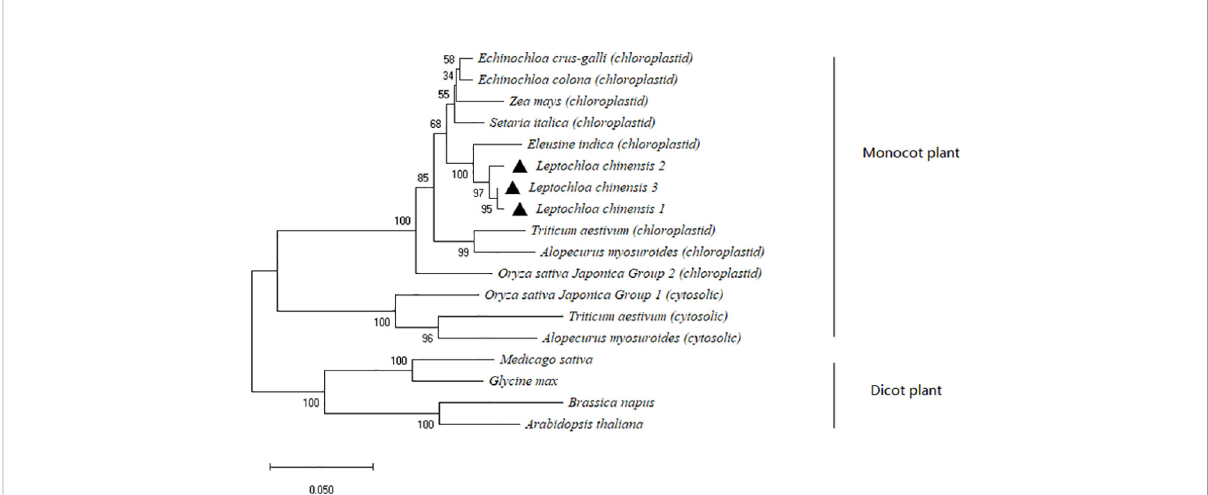
FIGURE 1 Phylogenetic analysis of the plant ACCase CT domain by the neighbor-joining method. (1) Each of the three types of ACCase CT domain in the susceptible Leptochloa chinensis population is labeled by a black triangle. (2) Monocot chloroplastid: Echinochloa crus-galli (NCBI accession No. ADR32358); Echinochloa colona (NCBI accession No. APZ87886); Zea mays (NCBI accession No. AAA80214); Setaria italica (NCBI accession No. AAL02056); Eleusine indica (NCBI accession No. AHC53984); Triticum aestivum (NCBI accession No. AAC39330); Alopecurus myosuroides (NCBI accession No. CAC84161); Oryza sativa Japonica Group 2 (NCBI accession No. B9FK36). (3) Monocot cytosolic: Oryza sativa Japonica Group 1 (NCBI accession No. Q8S6N5); Triticum aestivum (NCBI accession No. AAC49275); Alopecurus myosuroides (NCBI accession No. CAF74936). (4) Dicot: Medicago sativa (NCBI accession No. AAB42144); Glycine max (NCBI accession No. AAA75528); Brassica napus (NCBI accession No. CAC19875); Arabidopsis thaliana (NCBI accession No.